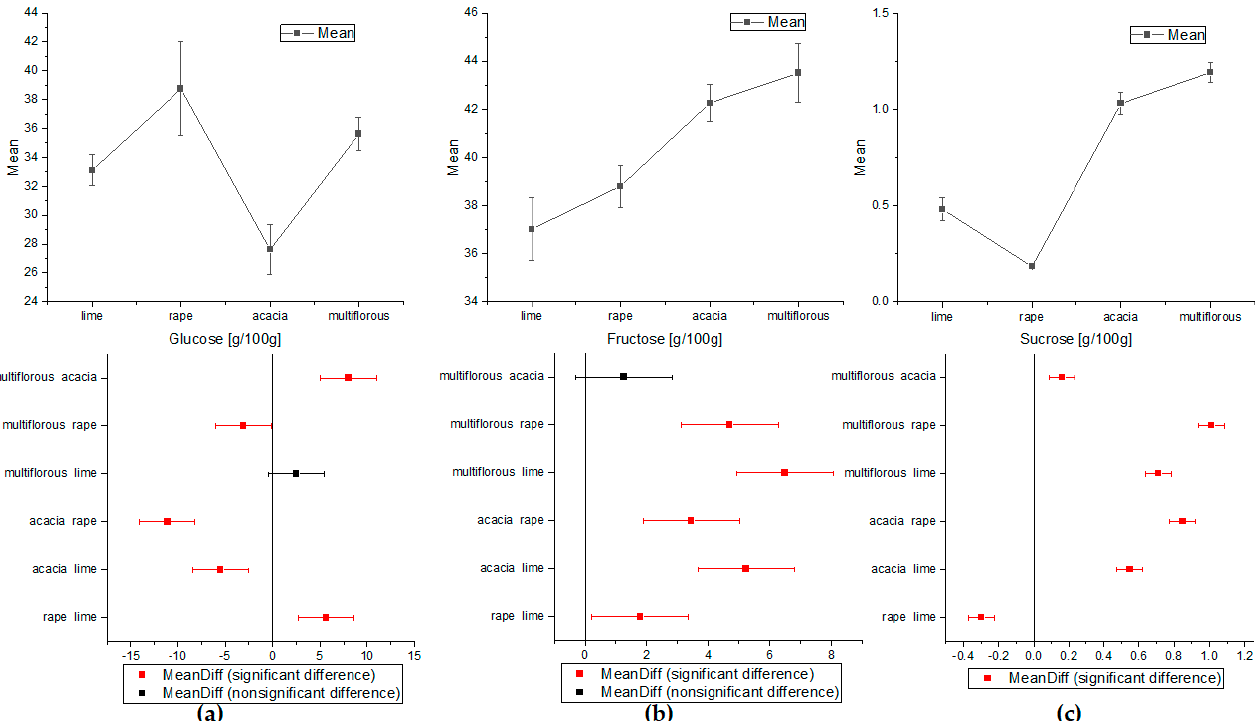
Figure 2. The comparison of the average means of sugars content obtained by ANOVA: ( a ) for glucose, ( b ) for fructose, and ( c ) for sucrose (Tukey test, p < 0.05).